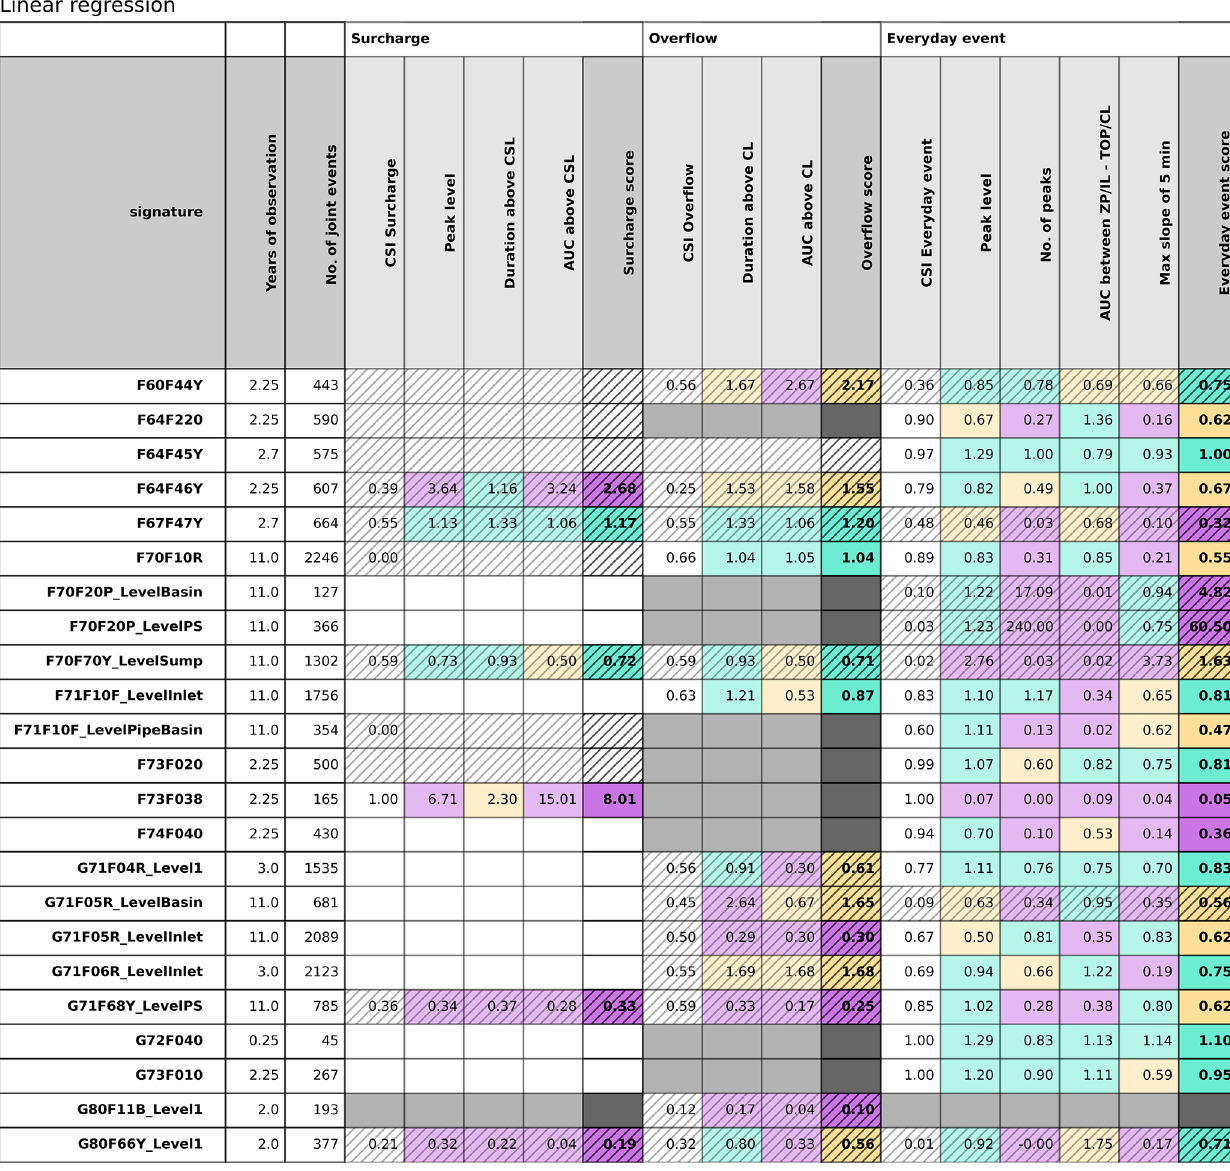
Table 6. Table of scores for linear regression with weighted events. The colours refer to the overall performance score; good (green), acceptable (yellow/orange) and poor (red/purple). The white area is where there are not enough true positives to evaluate a score (no. < 3; see Fig. 2). The hatched areas refer to the categorical analysis where too many events are not true positive, meaning that they are not modelled or observed. The grey/black area indicates where analysis is not possible due to physical constraints at the site; for example, not all sites have a crest level, and evaluation of overflow is thus not